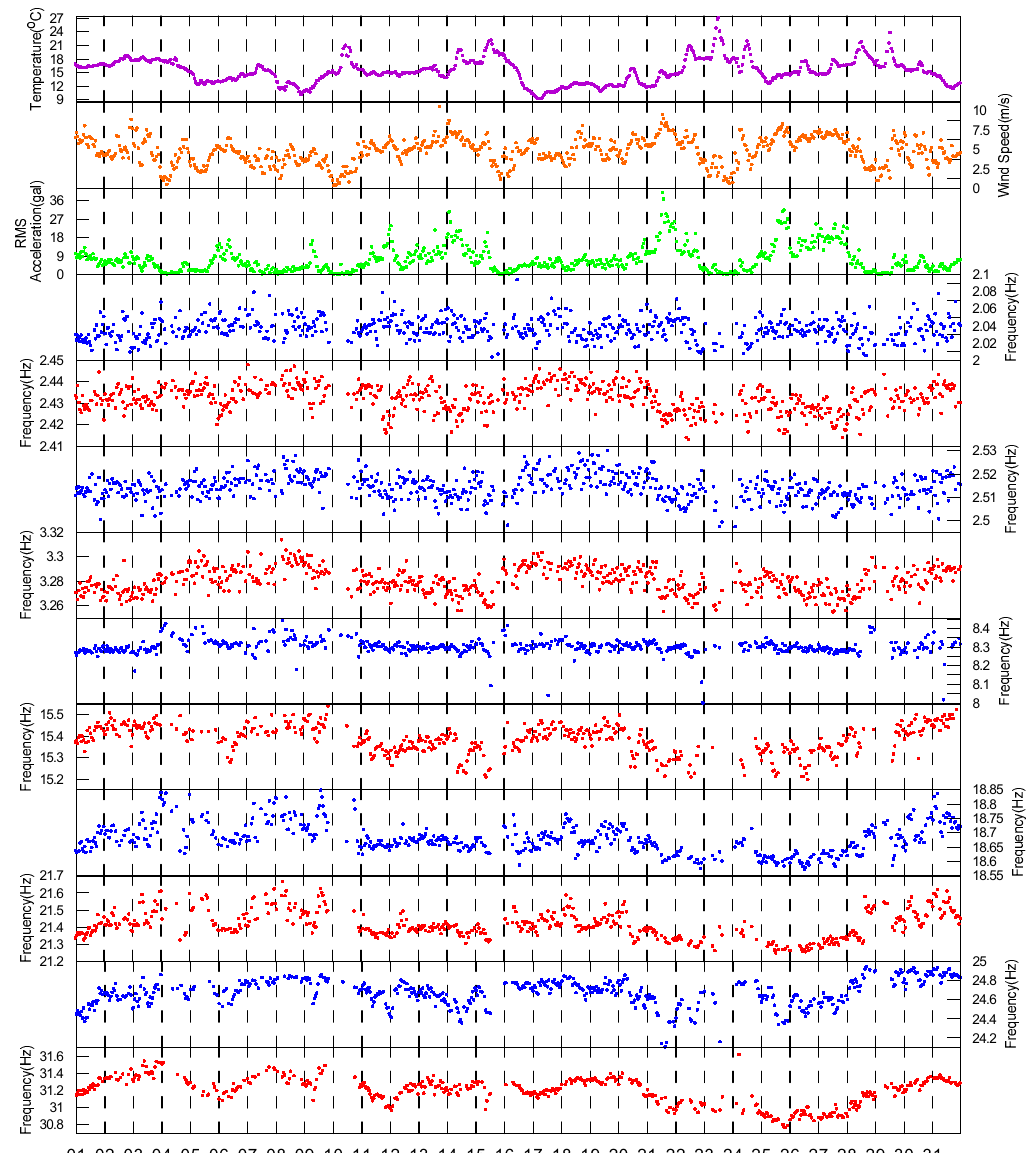
Figure 12. Comparison of identified modal frequencies while considering three different environmental factors in December of 2017.